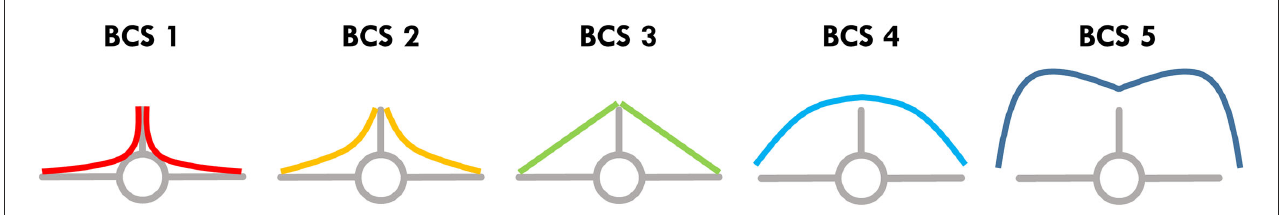
FIGURE1 Schematic cross section through the lumbar spine. BCS in llamas and alpacas is assessed by palpating the tissue coverage of the lumbar vertebrae. The spinous and transverse processes as well as the connecting line between these two are palpated. If the BCS is optimal (3), this connecting line is straight; if this line is concave, the BCS is < 3; if it is convex, the BCS is > 3. Figure modified according to Wagener and Ganter